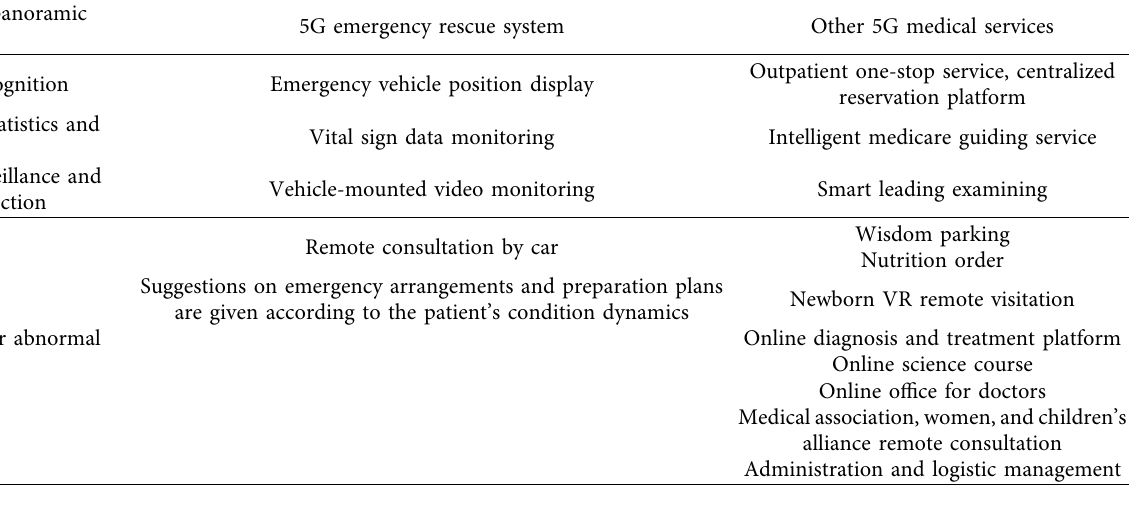
Table 3: A new model of 5G medical